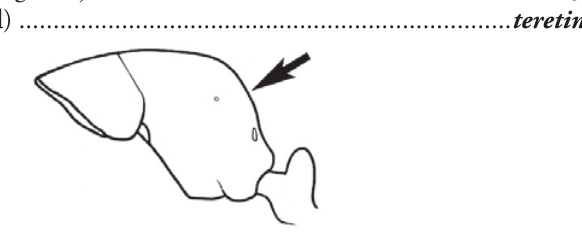
25 Mesonotum and propodeum of minor worker confluent, metanotal groove completely lacking (major worker unknown) (northern WA; NT) ( JDM